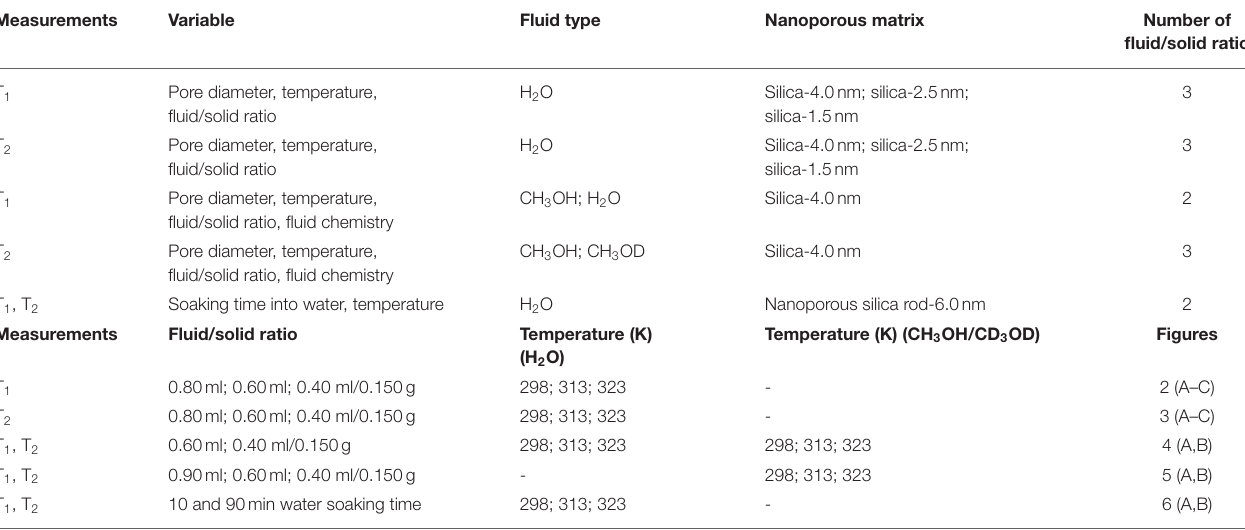
TABLE 1 | Experimental conditions of the low-field NMR measurements. Measurements